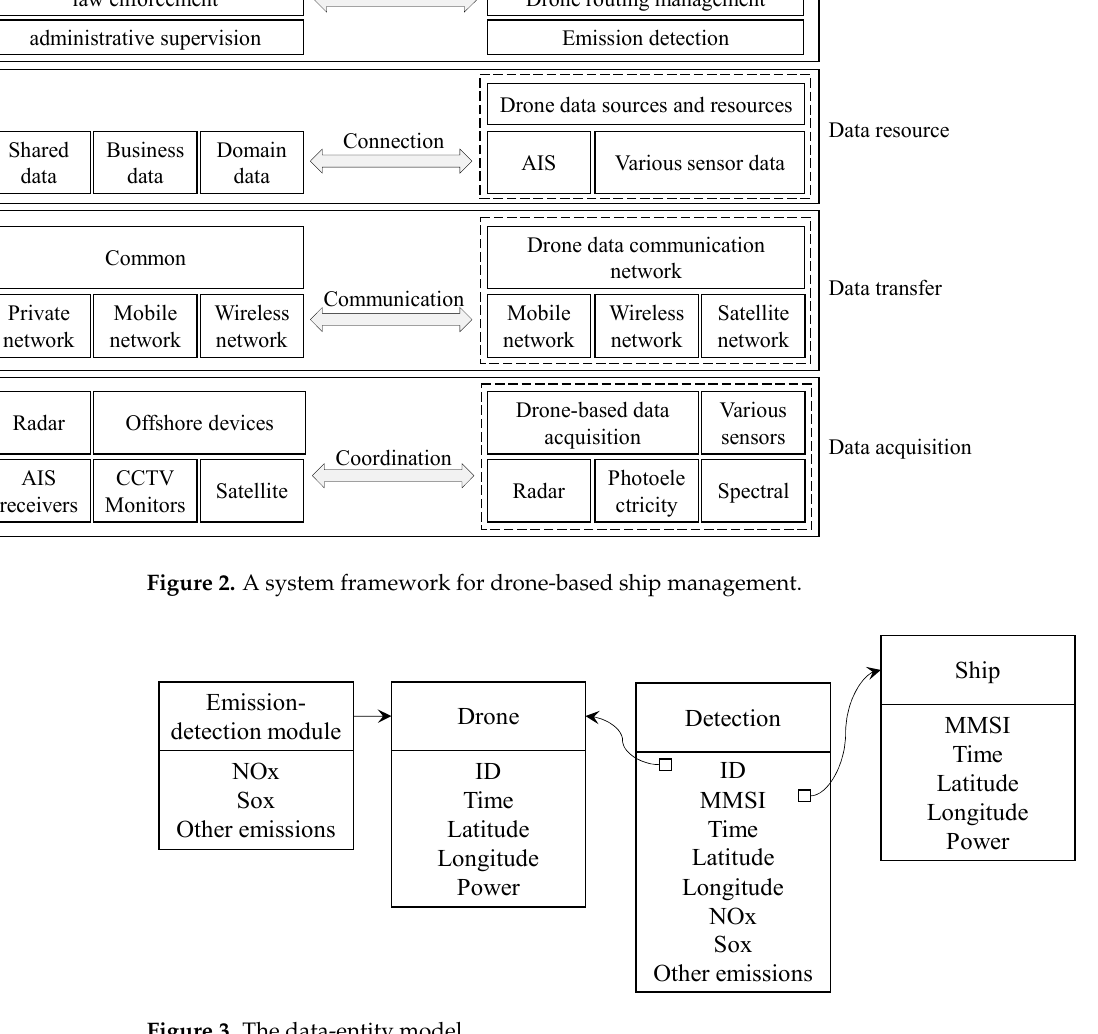
Figure 3. The data-entity model.